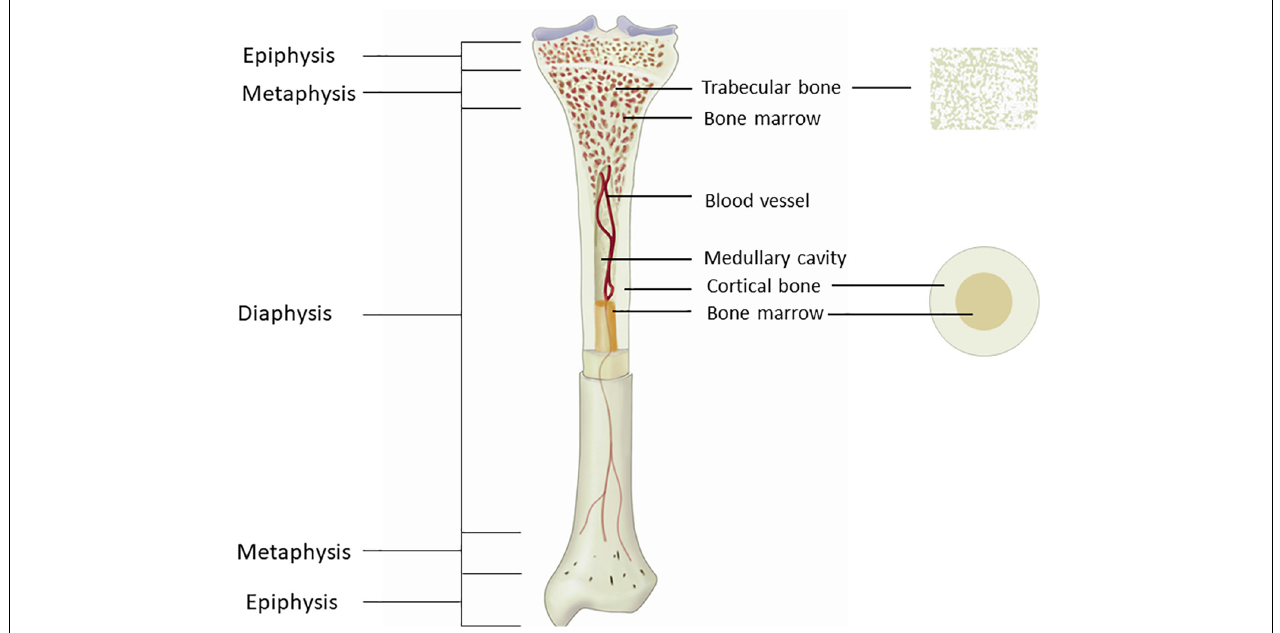
FIGURE 2 | Figure showing the anatomy of the tibia. The long bone shaft is consisted primarily of cortical bone, with large medullary cavity inside for bone marrow to reside. Trabecular bone is presented primarily at the end of the bone, with bone marrow resides between the trabeculae